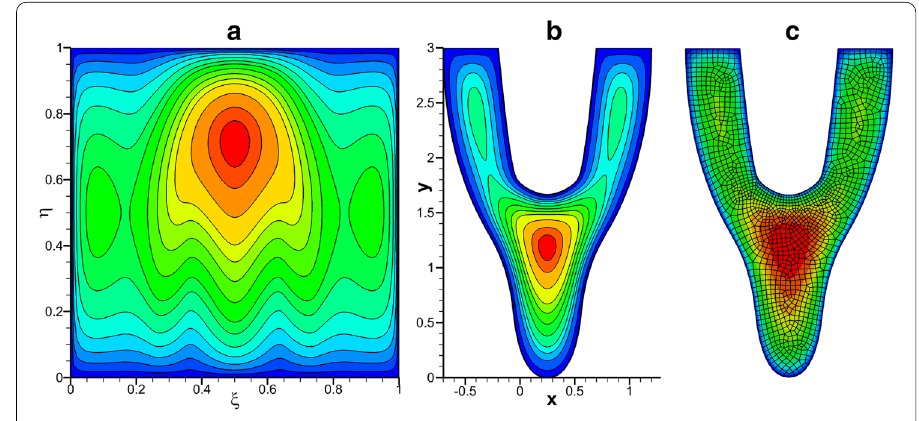
Fig. 8 Temperature field: In the computational domain ( a ); In physical domain ( b ); and reference solution obtained by using a commercial FEM solver